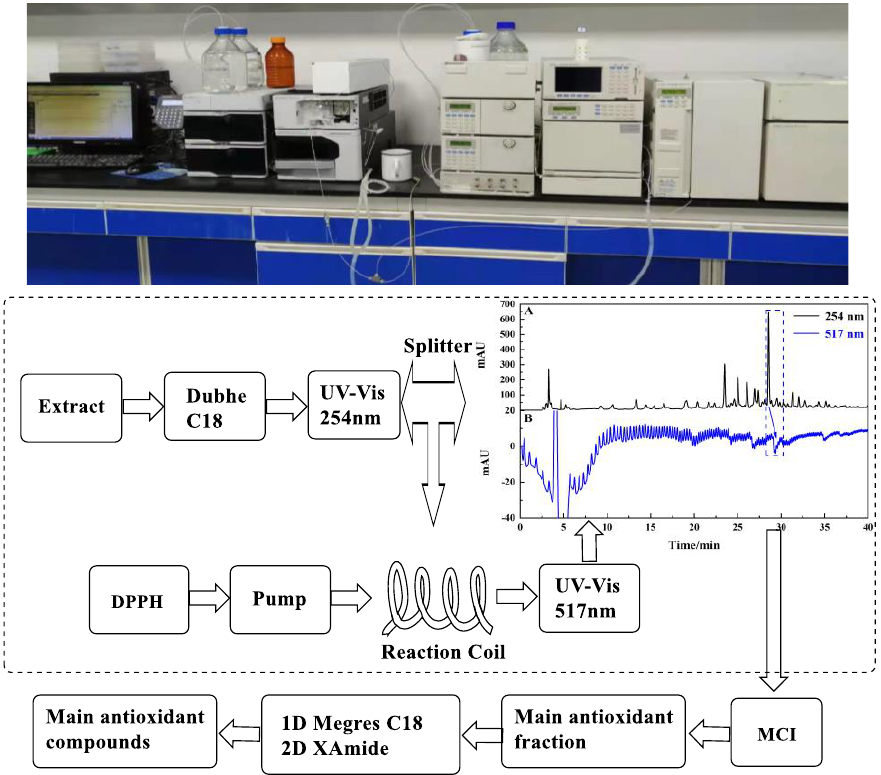
Figure 1. Scheme of performed experiment and used scientific equipment.